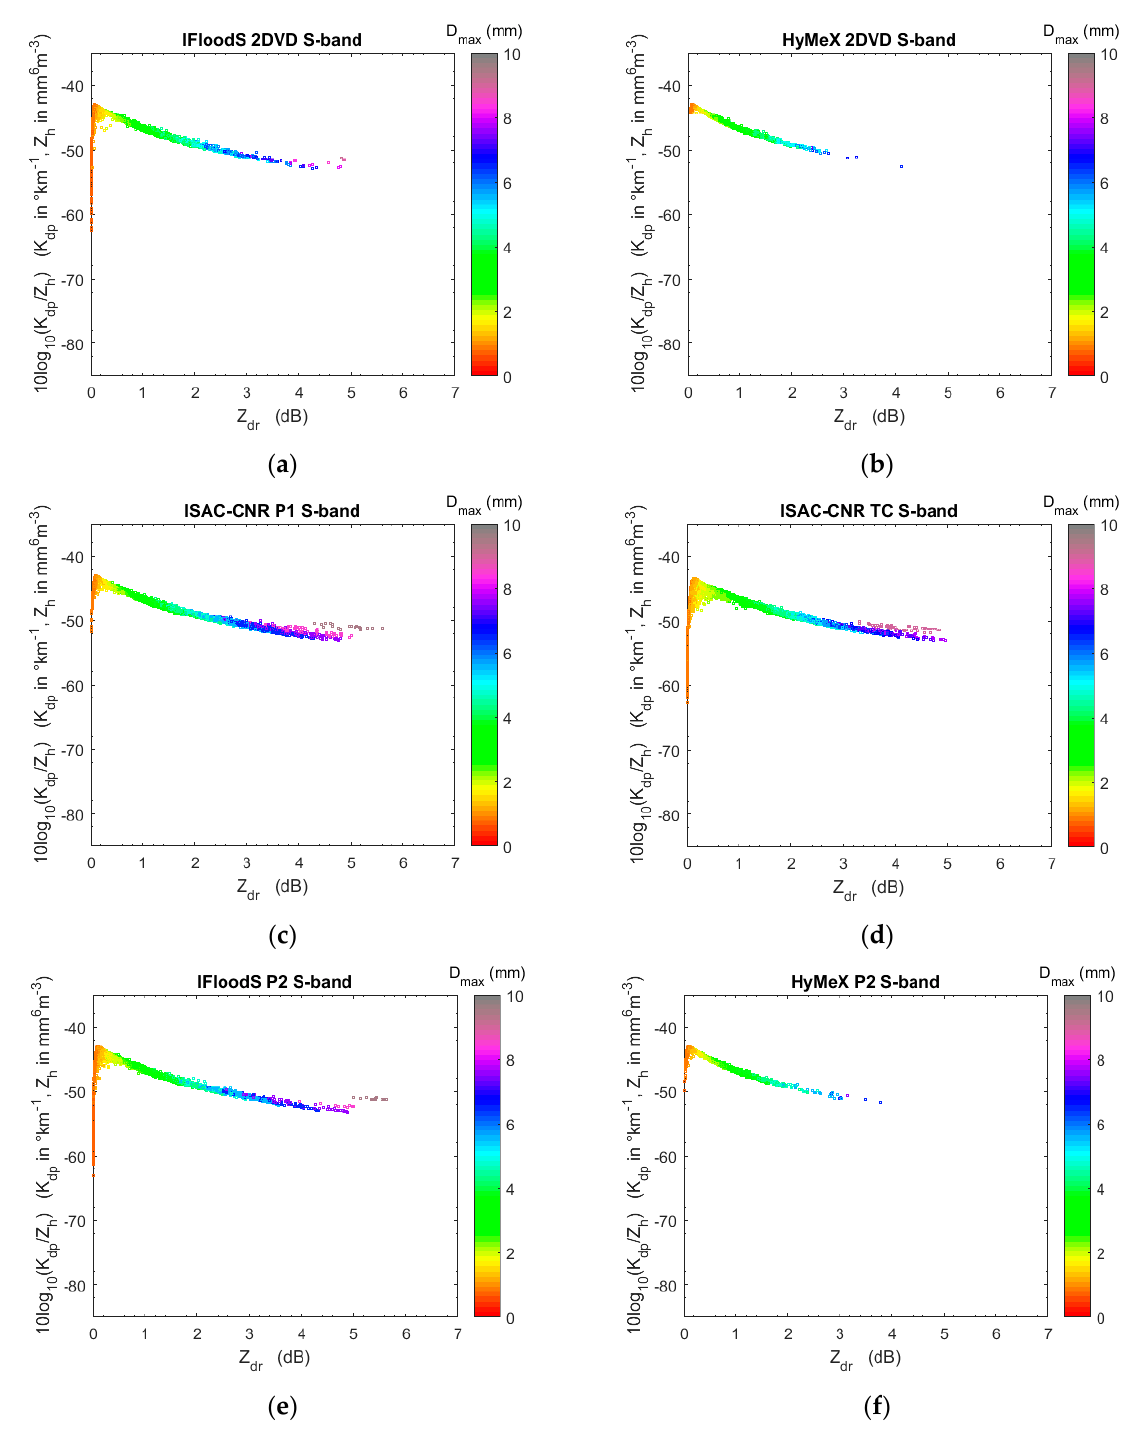
Figure 2. Scatterplot between the ratio K dp / Z h as function of Z dr at S-band for the different datasets considered in this study. The colorbar indicates the values of the measured maximum drop diameter ( D max ). ( a ) IFloodS 2DVD dataset; ( b ) HyMeX 2DVD dataset; ( c ) ISAC-CNR P1 dataset; ( d ) ISAC-CNR TC sataset; ( e ) IFloodS P2 dataset; ( f ) HyMeX P2